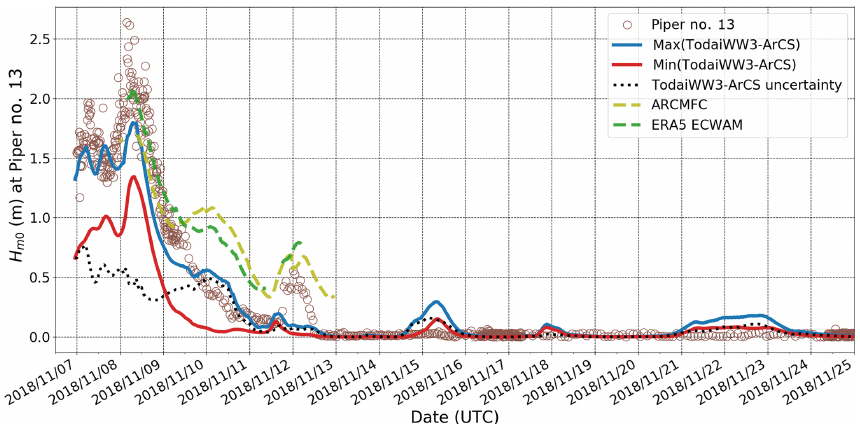
Figure 4. Piper no. 13 wave data are presented with TodaiWW3-ArCS H m interpolated at the Piper no. 13 positions. Two independent predictions from ERA5 ECWAM and the ARCMFC wave model are also